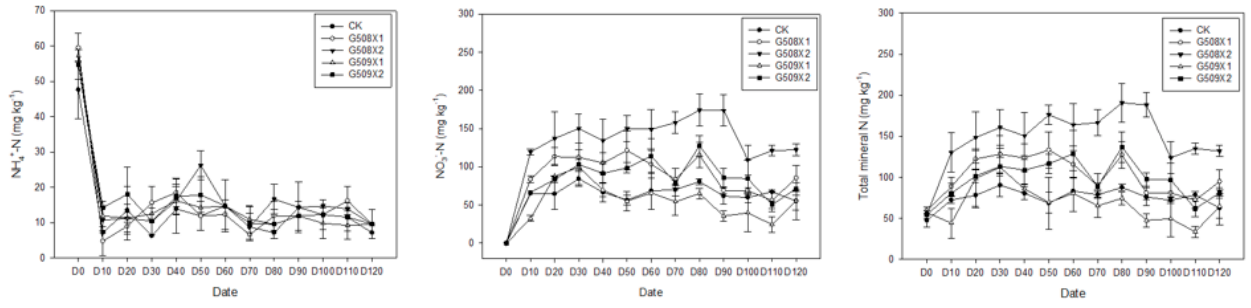
Figure 5. Concentrations of 2 M KCl-extractable NH 4+ -N, NO 3 − -N, and total mineral N in the soils of the incubation experiment under different treatments ( n = 3).